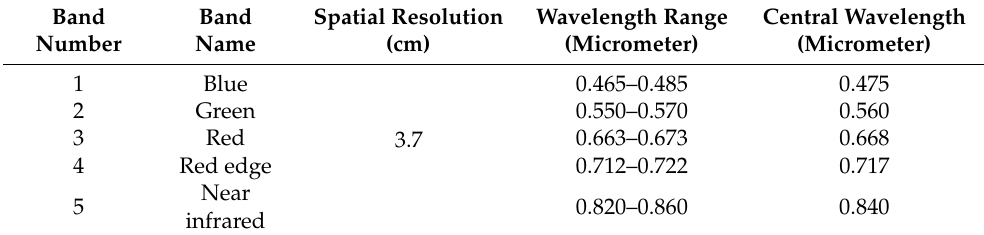
Table 2. Band and spatial resolution parameters of the multispectral data.